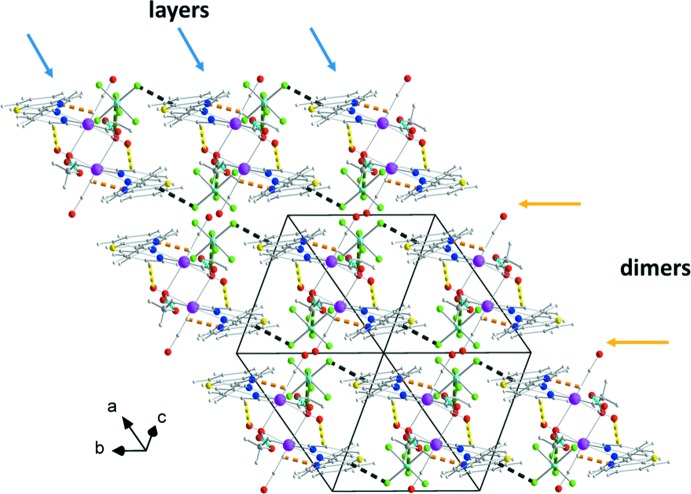
Three-dimensional arrangement of layers. C9—H9⋯F3ii hydrogen bonds are indicated by black dashed lines. For the atoms and the rest of the bonds, the colour code is as in previous figures. The cyan arrows indicate the position of the layers within the structure and the orange ones the areas where the complexes inter­act through π–π inter­actions.